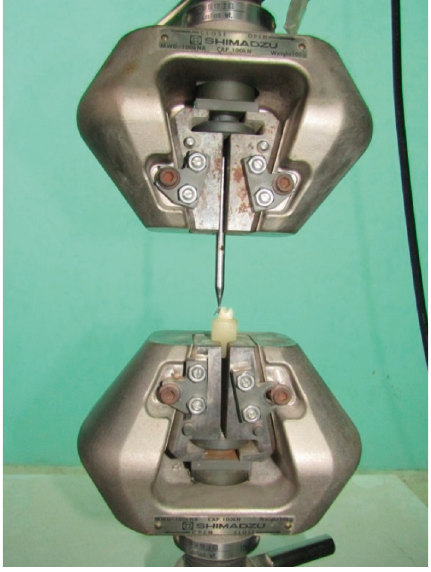
Figure 4: Close view of crosshead of the universal testing machine with sample in situ.